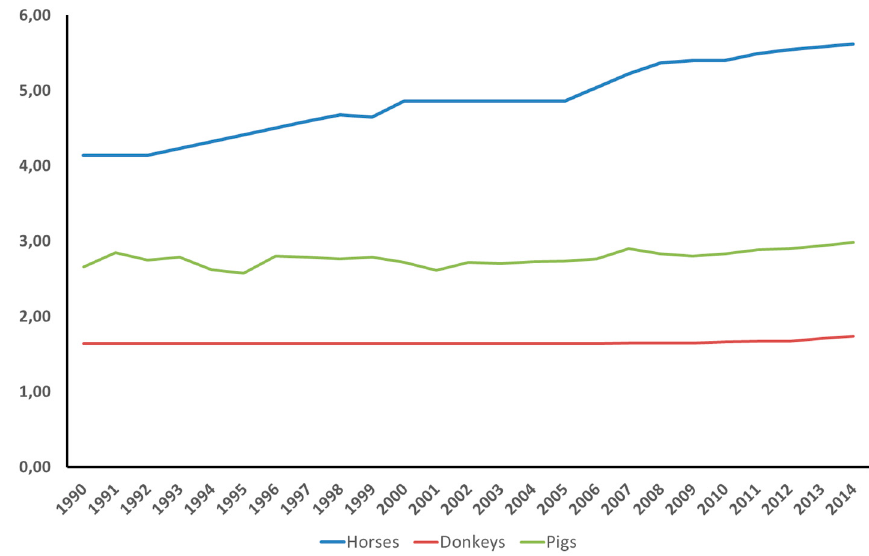
Figure 6. Enteric emissions (Gg CH 4 ) for South African horses, donkeys and pigs from 1990 to 2014.